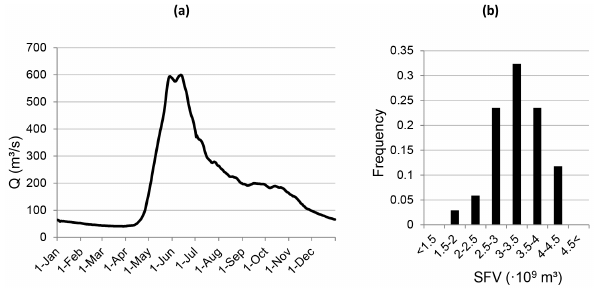
Figure 2. Mean annual Q cycle (a) and SFV frequency distribu- tion (b) for station Vindeln in the period